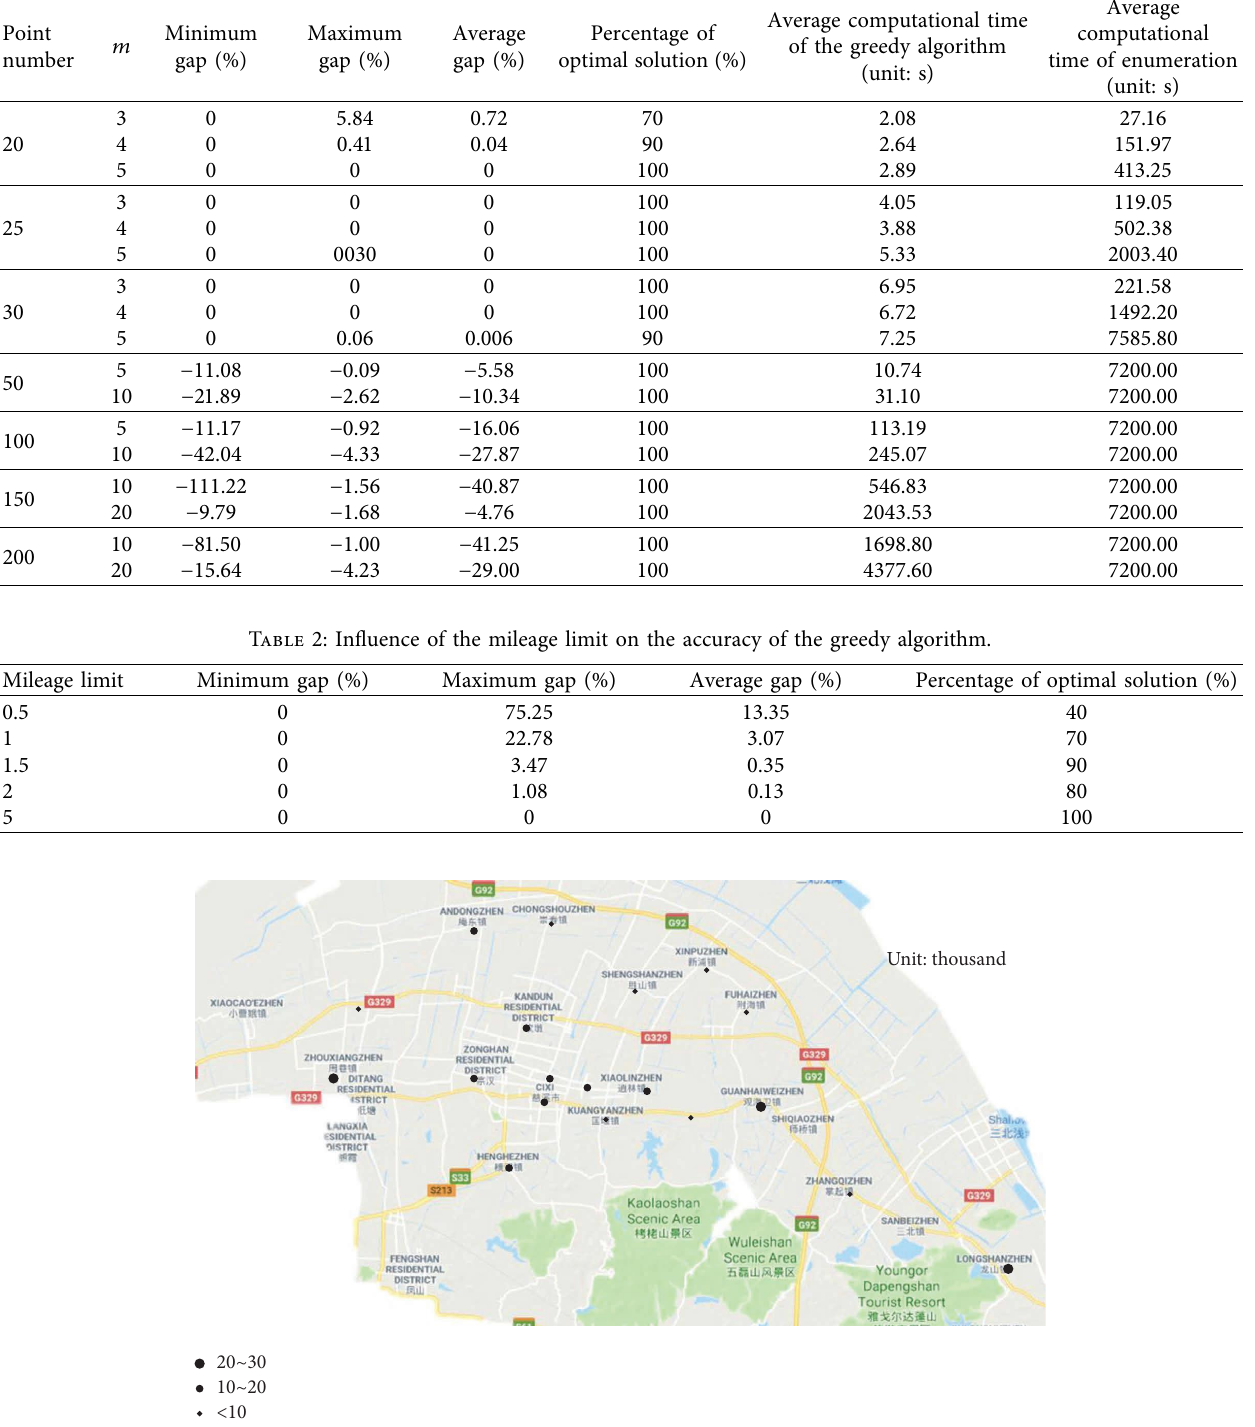
Table 1: Performance of the greedy algorithm.